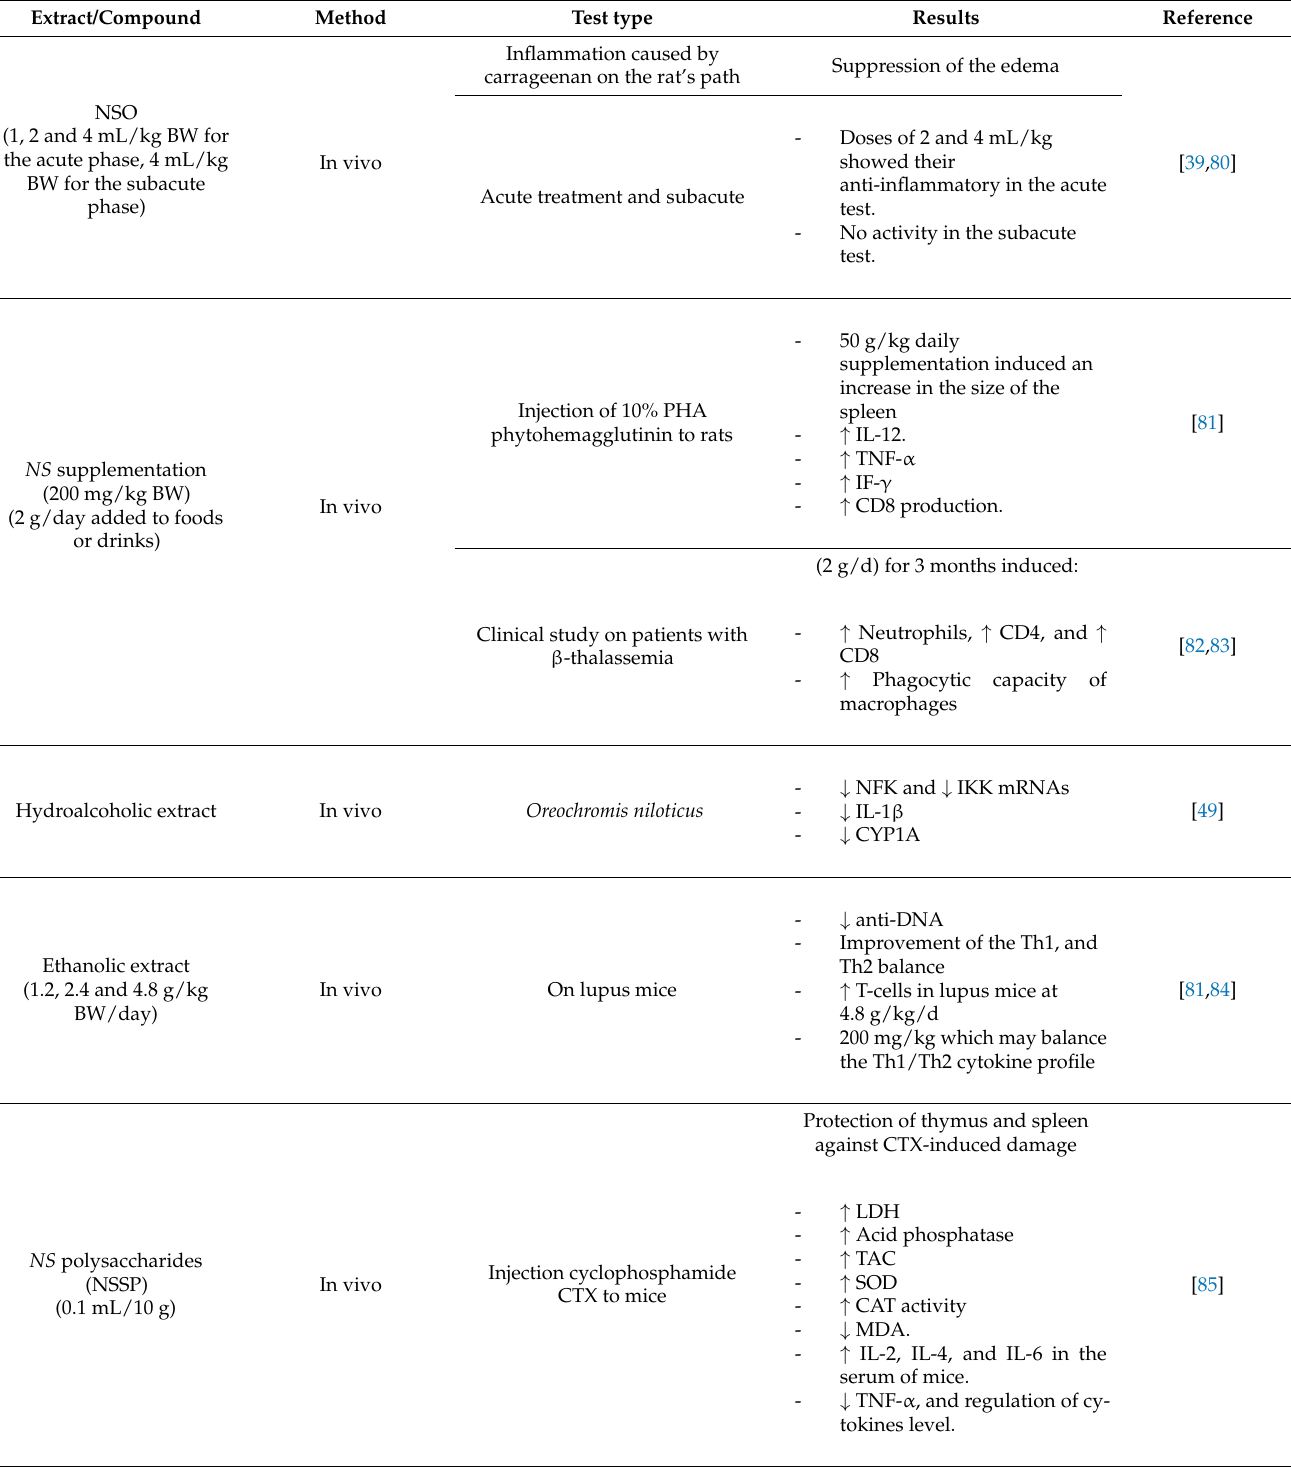
Table 4. Summary of the anti-inflammatory and immunomodulatory activities of